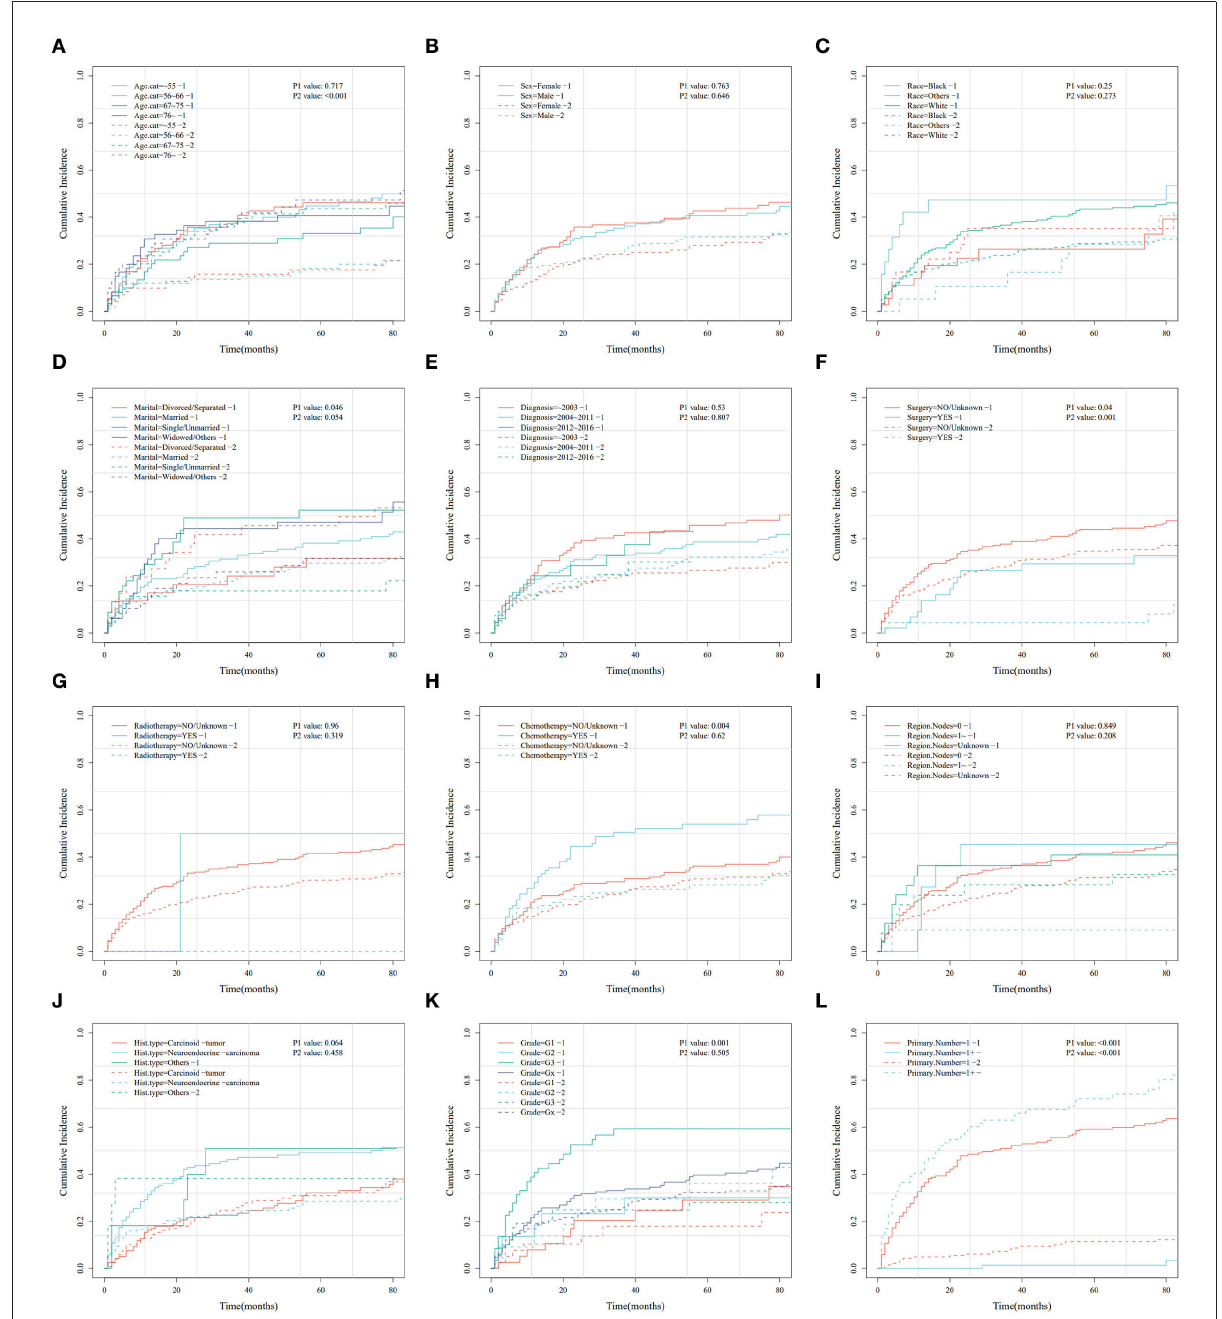
FIGURE3 Cumulative risk curve analysis of the influence of the main variables on the cumulative probabilities for primary hepatic neuroendocrine tumor (PHNET)-specific death (labeled by 1) and non-PHNET death (labeled by 2) in the training set. (A) age; (B) sex; (C) race; (D) marital status; (E) year of diagnosis; (F) surgery; (G) radiotherapy; (H) chemotherapy; (I) number of regional lymph nodes; (J) histological type; (K) grade; and (L) number of primary